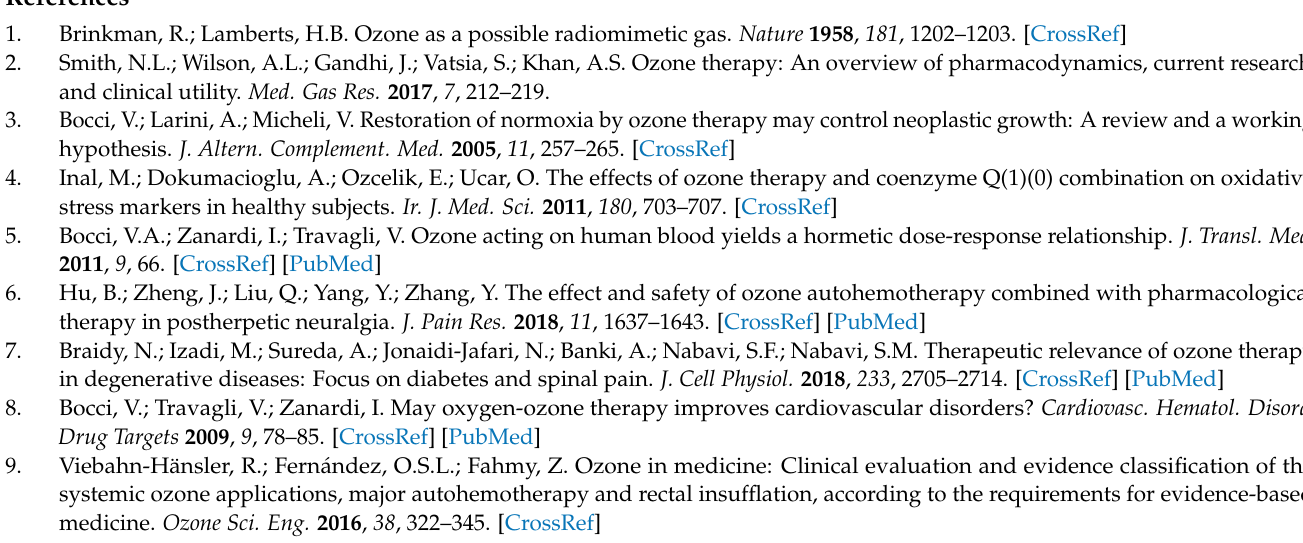
Figure S2: The representative light-scatter dot plot demostrating the MP region and representative fluorescence plots of labeled samples (ozonated blood); Table S1: titleDescriptive statistics of the obtained